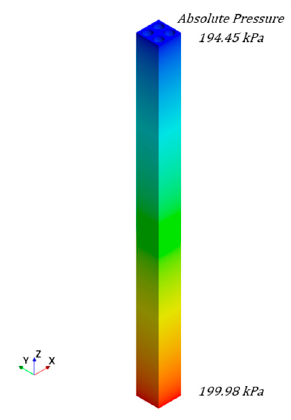
Figure 6. Pressure distribution of numerical analysis results in Case 1.